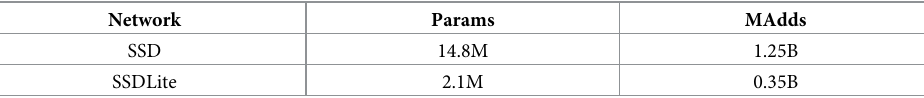
Table 4. Comparison of the size and the computational cost between SSD and SSDLite configured with